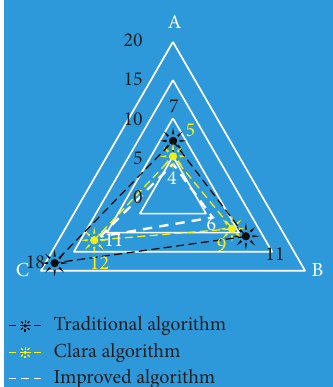
Figure 8: Comparison of the number of clustering iterations.